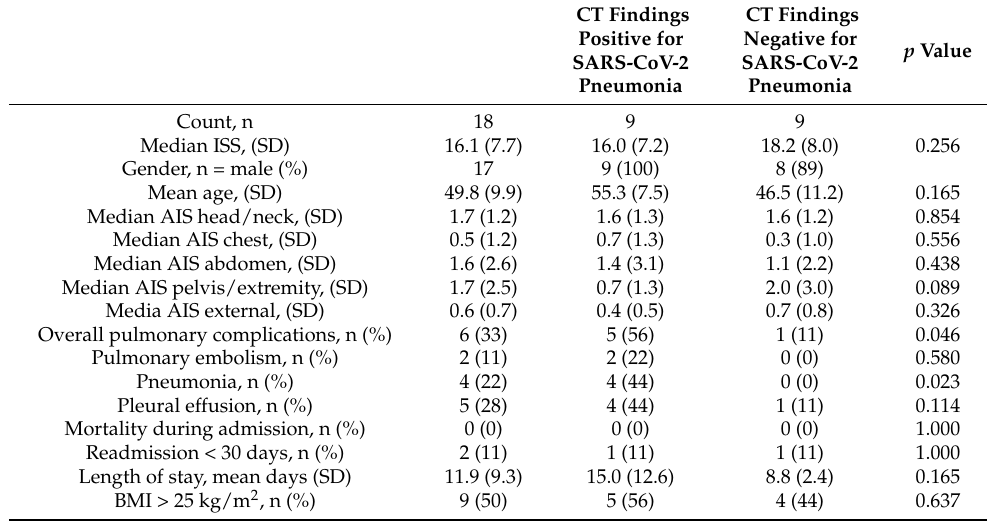
Table 3. Age-adjusted pair-matched analysis of polytrauma patients with SARS-CoV-2 infection and positive CT